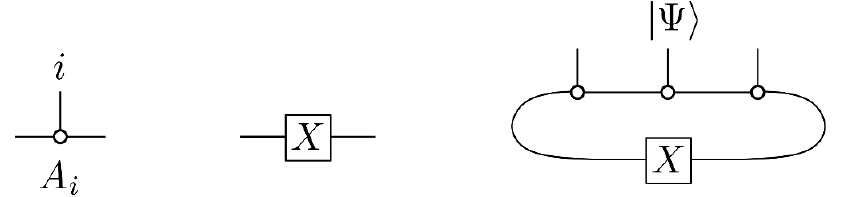
Figure 1 . This (cid:12)gure illustrates an MPS with n = 3 physical spins, de(cid:12)ned in terms of a family f A j g p of matrices and a matrix X j =1